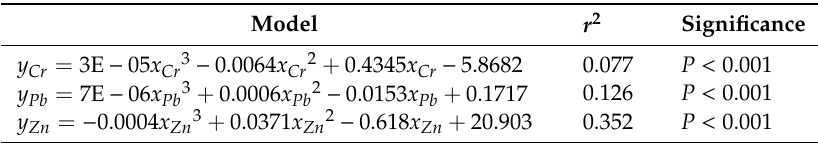
Table 5. The optimal curvilinear regression models of the Cr, Pb and Zn concentrations in the soil-wheat